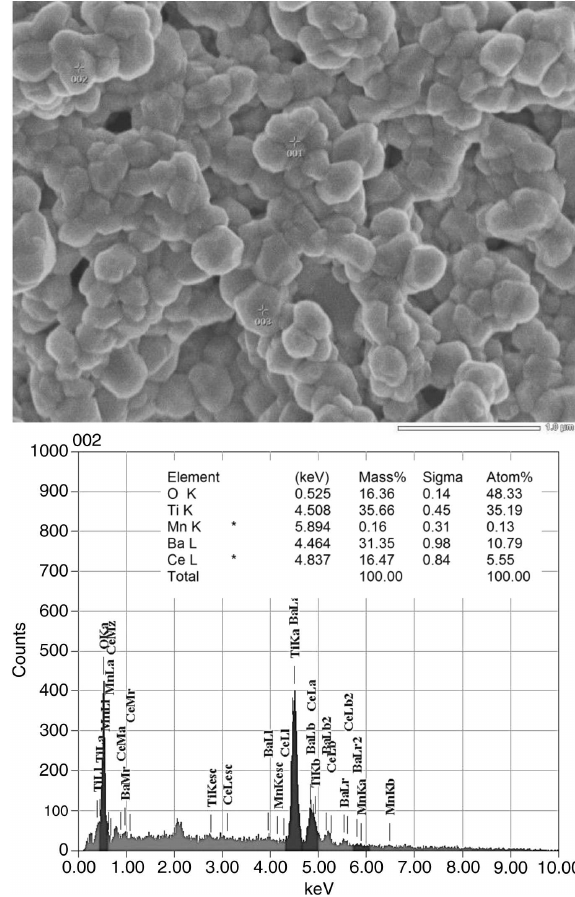
Figure 4: SEM and EDX spectrum of the Ba 1 − x Ce x Ti 1 − y Mn y O 3 (x = y = 0.02) sample and the elemental